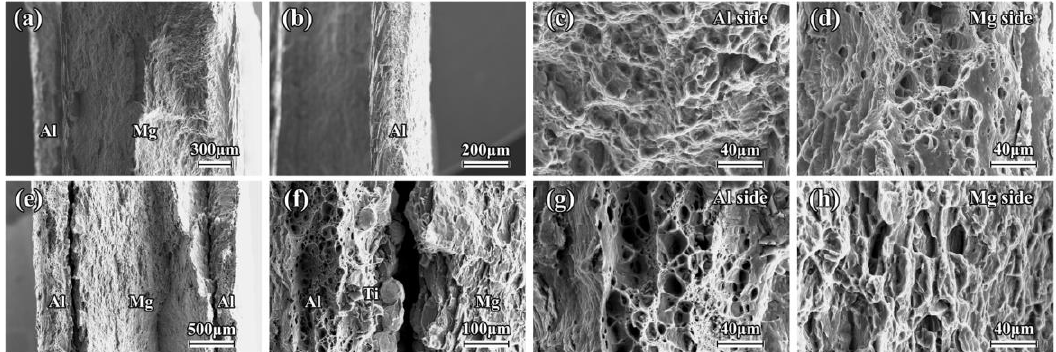
Figure 11. Tensile fracture features of composite sheets annealed at 400 °C for 3 h: ( a – d ) Mg/Al sheet, and ( e – h ) Mg/Al - Ti sheet.